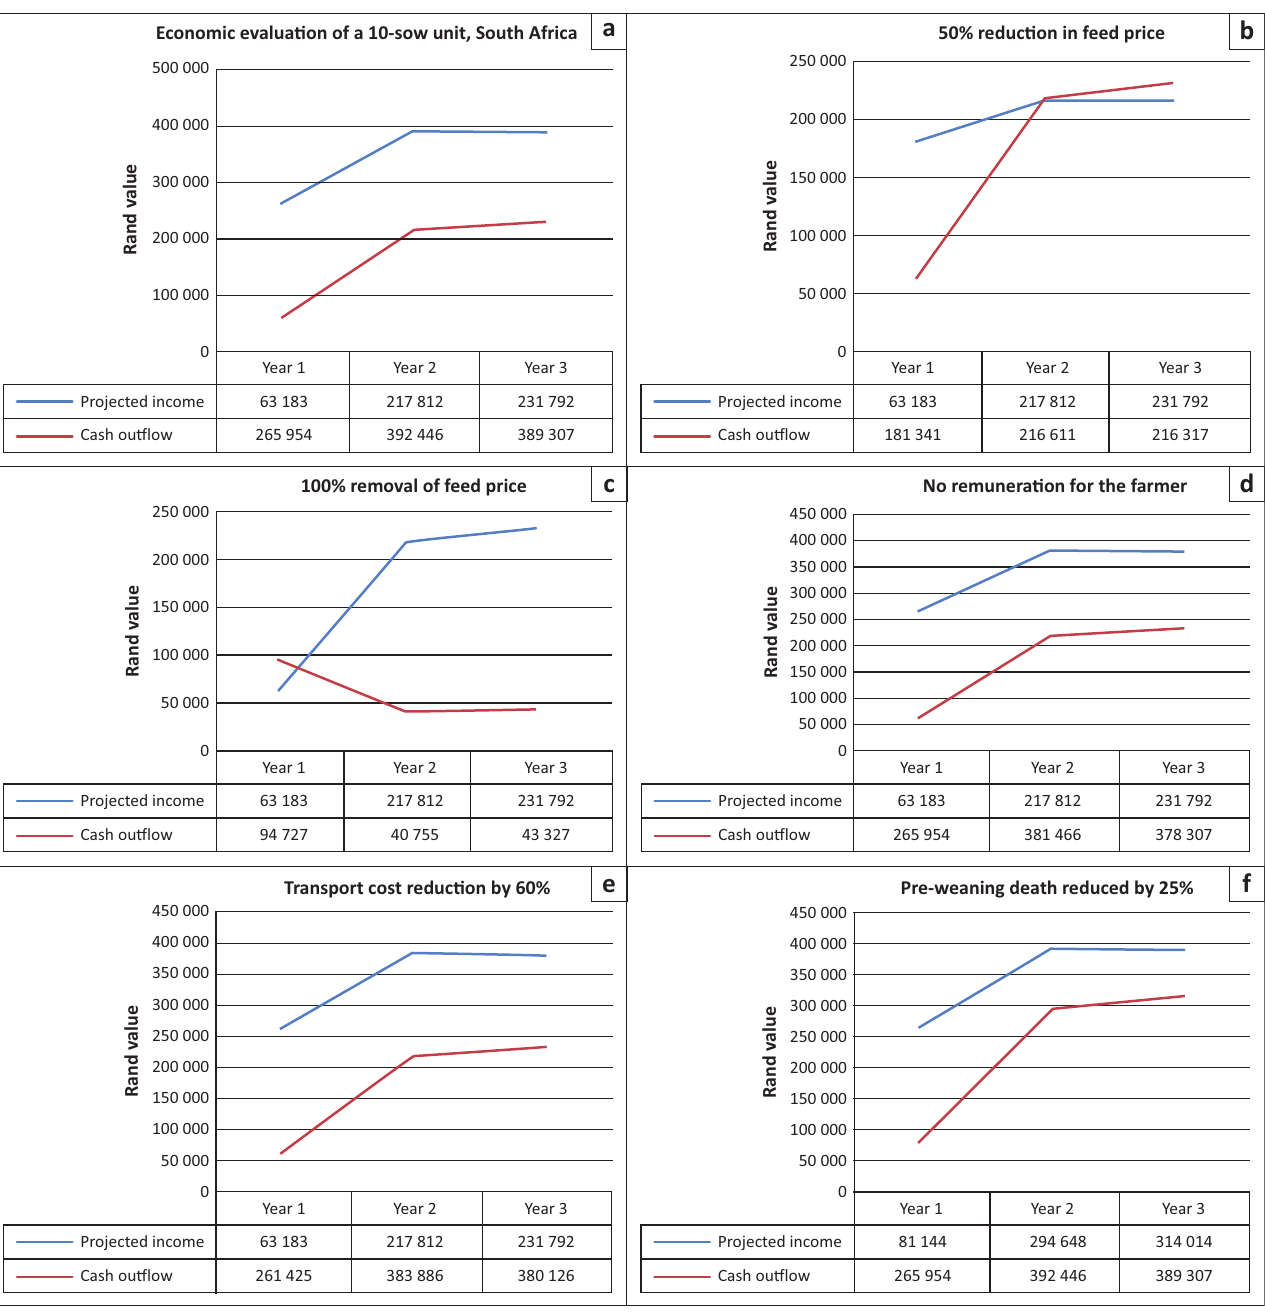
FIGURE 2: Economic evaluation of a 10-sow unit using different scenarios. (a) Economic evaluation of a 10-sow unit, South Africa, (b) 50 % reduction in feed price, (c) 100 % removal of feed price, (d) No remuneration for the farmer, (e) transport cost reduction by 60 % and (f) preweaning death reduced by 25 %